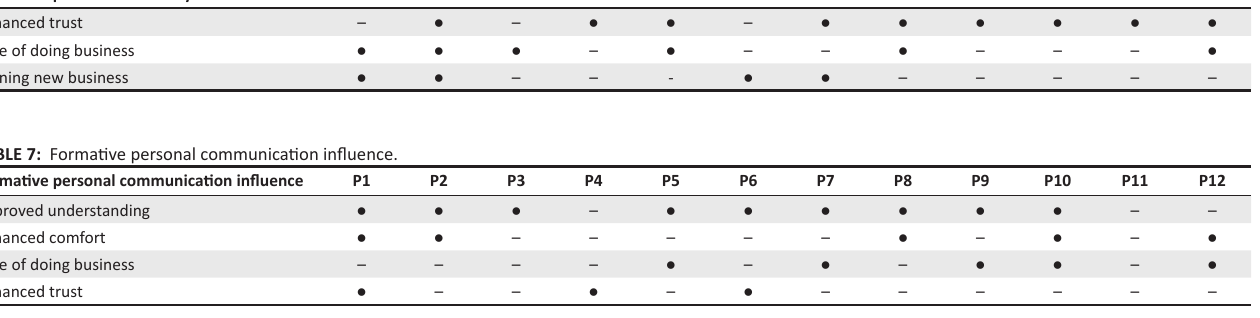
TABLE 6: Formative personal credibility influences. Formative personal credibility influences